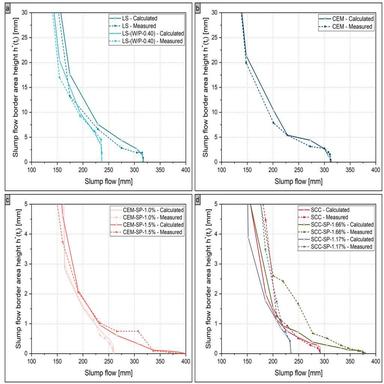
Comparison of measured and calculated slump flow border area profile heights for different viscous mixture compositions.